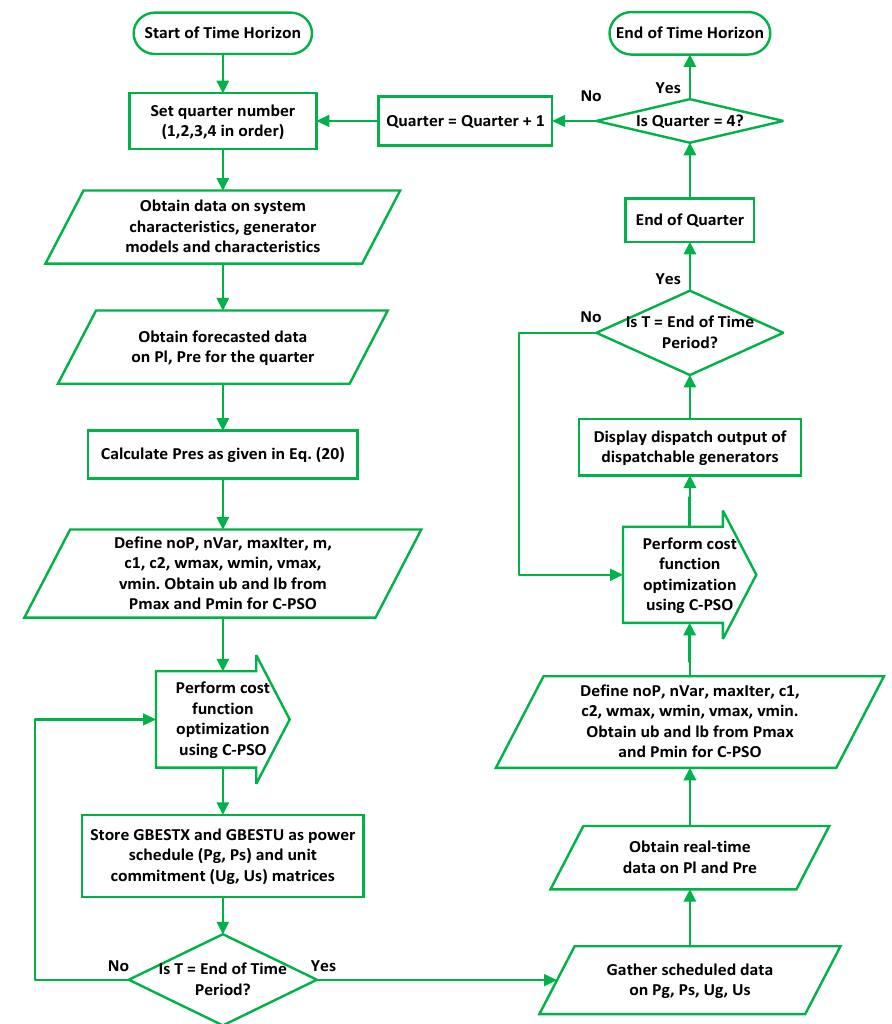
Figure 3. Flowchart depicting the split-horizon dual-stage dispatch strategy.